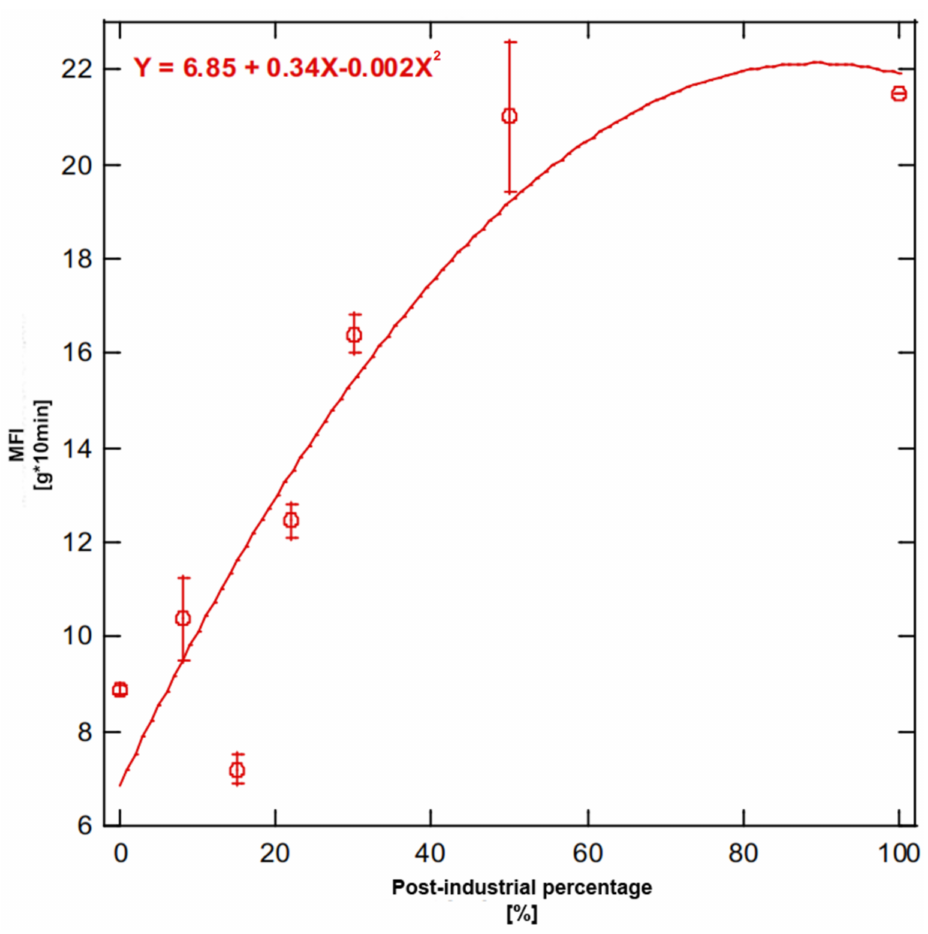
Figure 9. Melt flow index for each blend ordered by post-industrial plastics